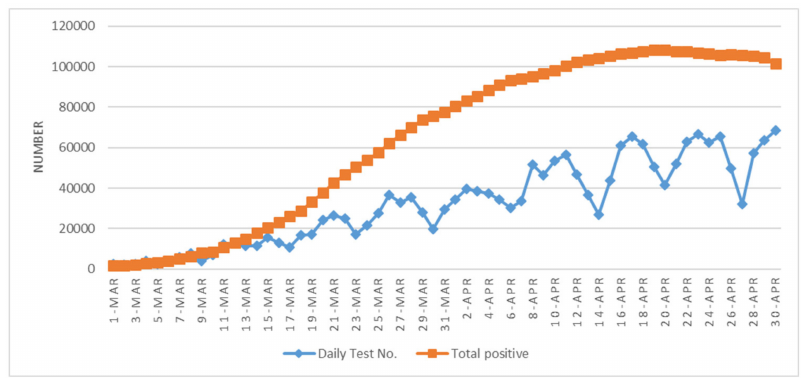
Figure 4. Daily tests and total positive cases in the whole of